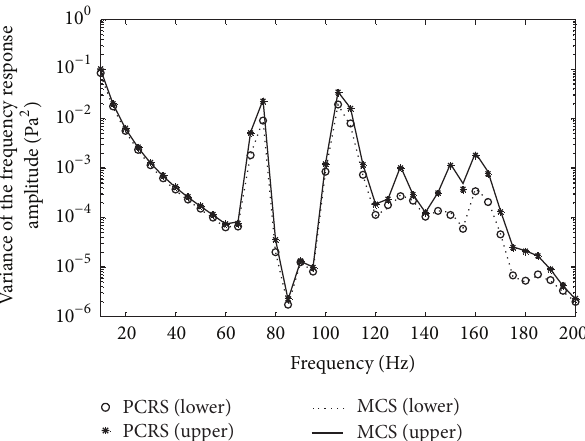
Figure 13: The lower and upper bounds of variance of the frequency response amplitude at node 𝑅1 calculated by PCRS and MCS in the frequency band 𝑓 = 10 ∼ 200Hz.